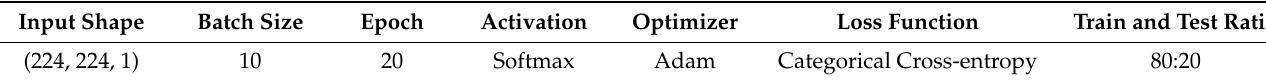
Table 6. CNN Functional Parameters.